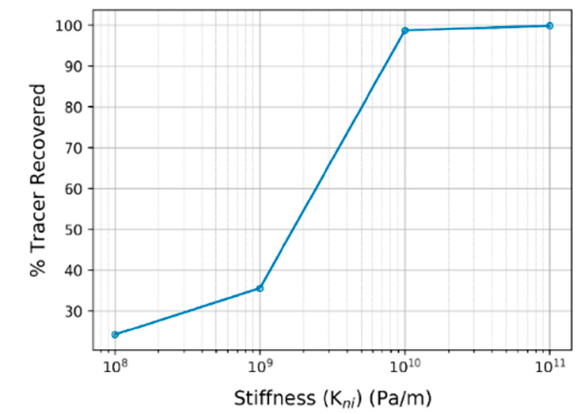
Figure 12. Flowback tracer recovery vs. time for several fracture stiffness values.